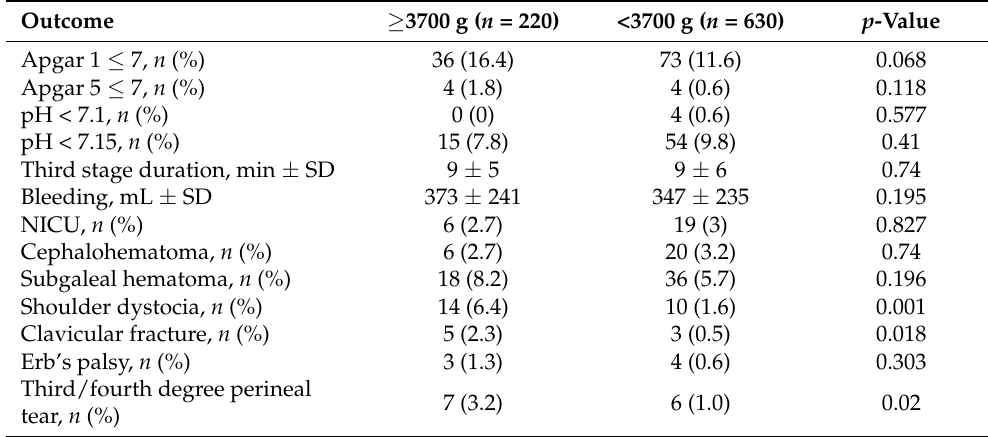
Table 3. Maternal and neonatal outcomes in relation to sonographic estimated fetal weight.